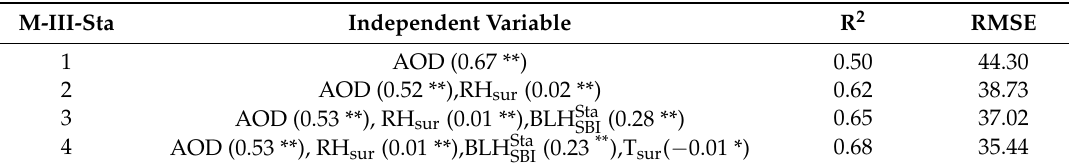
Table 3. Results of the stepwise regression of M-III-Sta (sample size n =